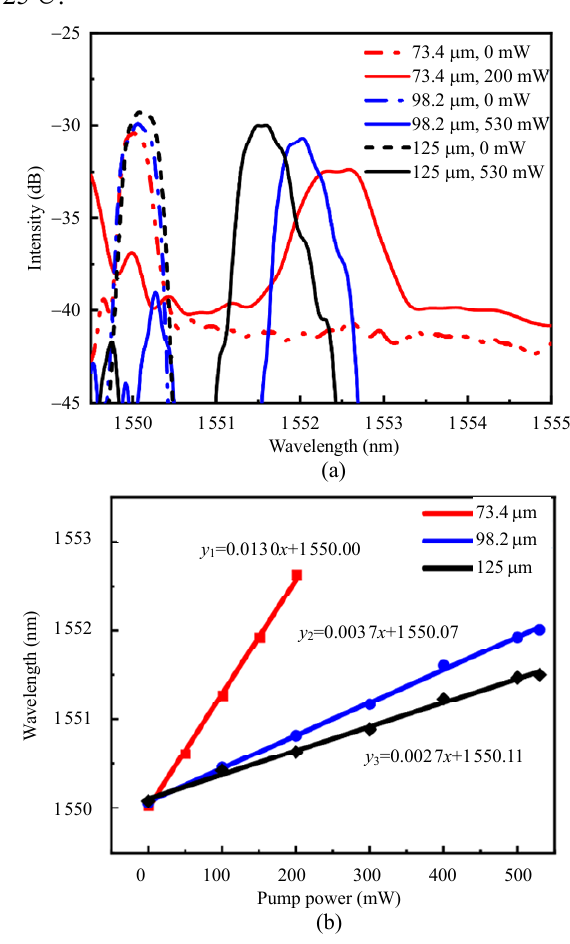
Fig. 3 Comparison of heating efficiency: (a) measured reflection spectra of the three FBG anemometer samples with or without laser heating and (b) measured center wavelength of the three FBG anemometer samples against pump laser